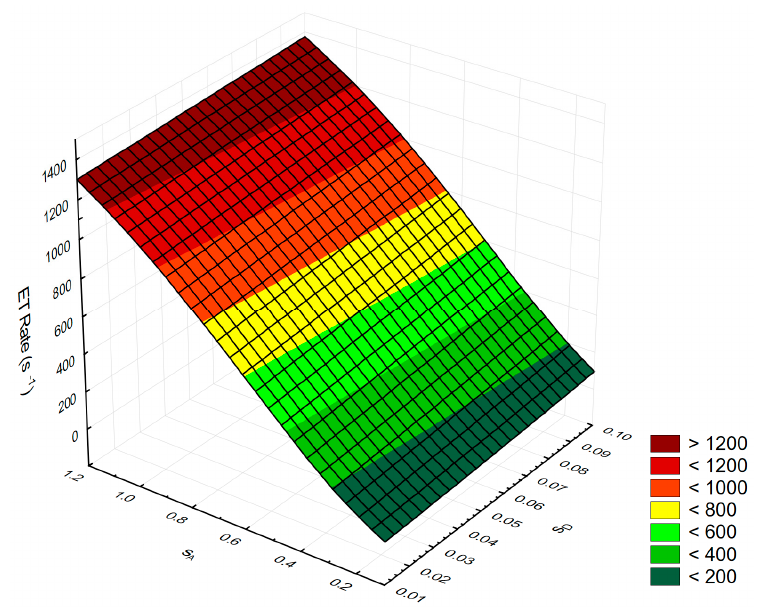
Figure 5. ET rate Eu(III) → Cr(III) as a function of the Huang–Rhys factors and considering the participation of 2 phonons in the ET process. s A and s D are the Huang–Rhys factors for the involved transitions of the Cr(III) and Eu(III) ions, respectively.